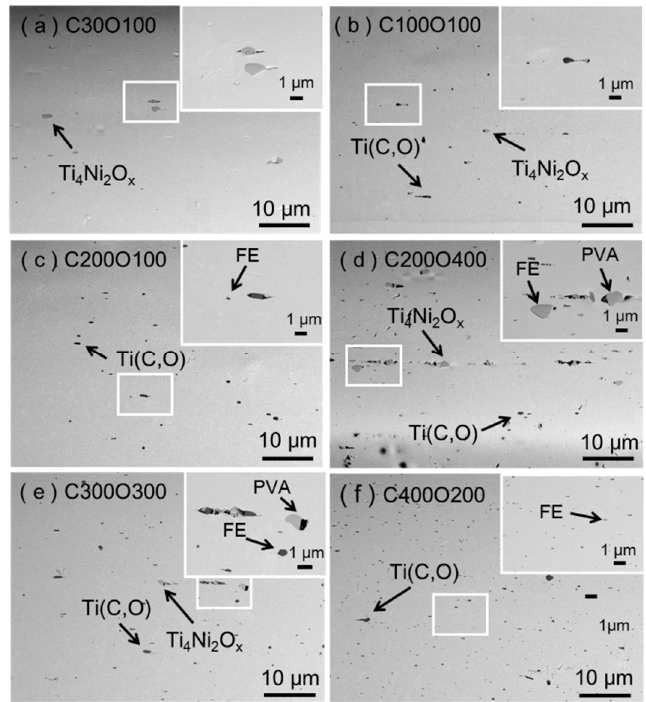
Figure 2. Scanning electron microscopy (SEM)-Backscattered electron (BSE) images of wire surfaces after electropolishing. ( a ) C30O100, ( b ) C100O100, ( c ) C200O100, ( d ) C200O400, ( e ) C300O300 and ( f ) C400O200. Insets in the upper right show enlarged micrographs taken from the framed area in each low-magnification images.